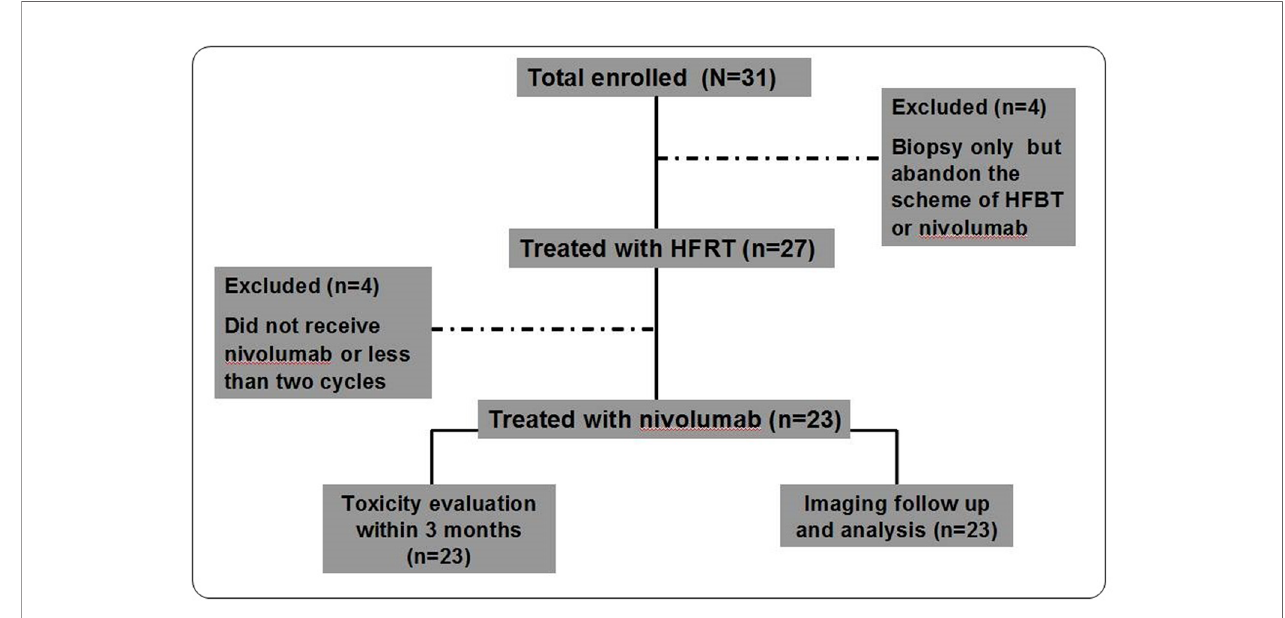
FIGURE 1 | Study Protocol Diagram. A total of 23 patients completed the trial and were examined in the analysis of short-term ef fi cacy and